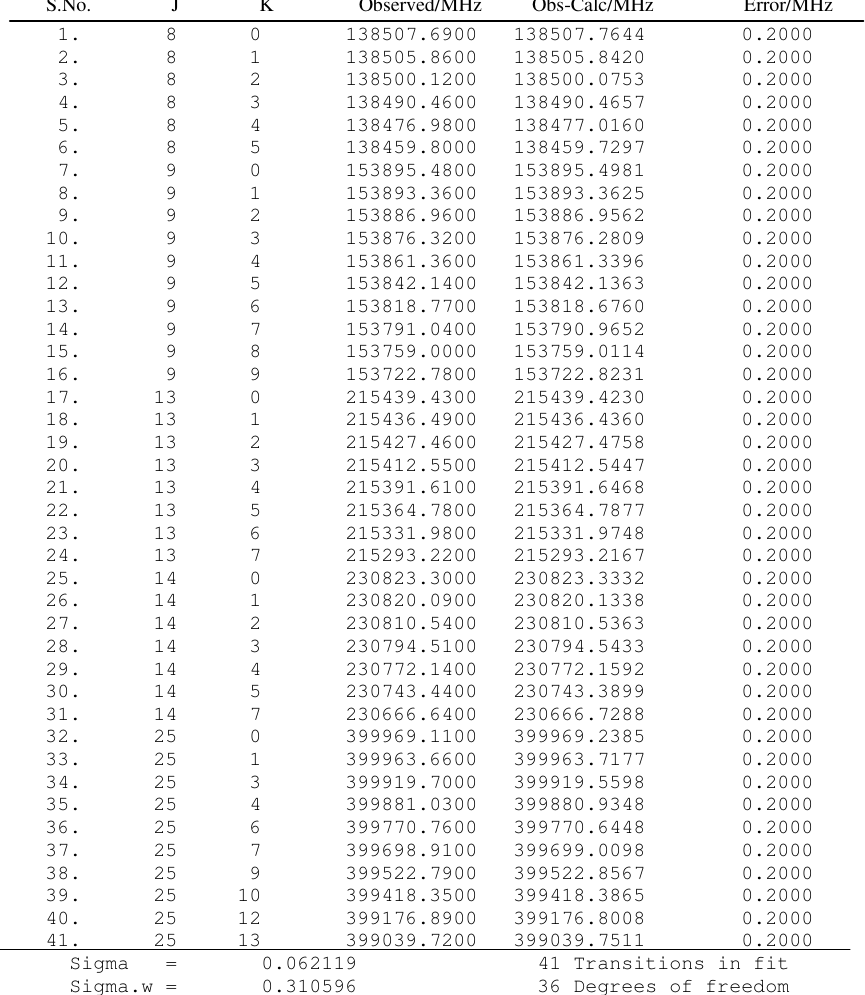
CN in the grounds state 22,25 . 3